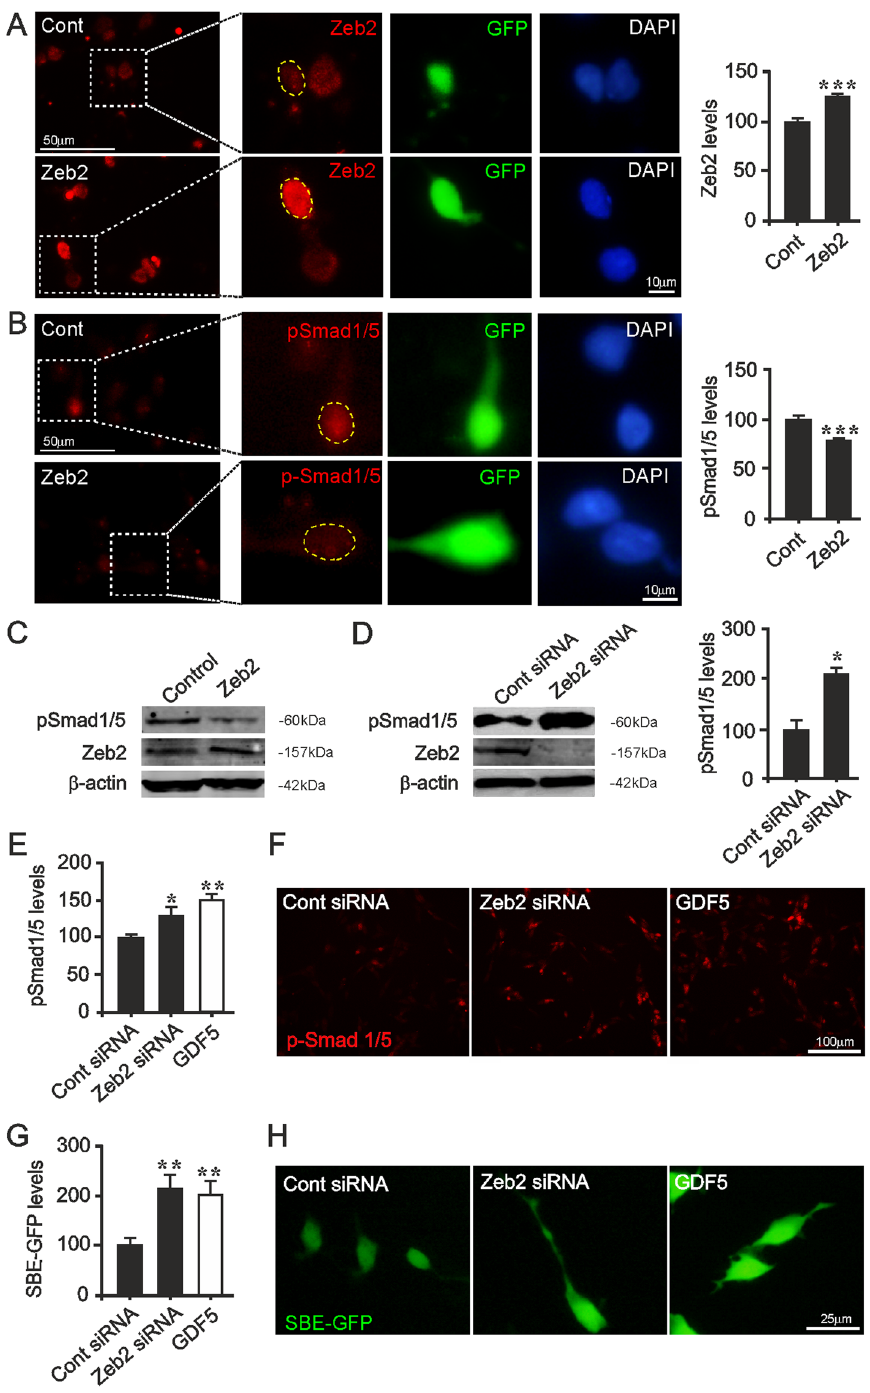
Figure 2. Zeb2 regulates p-Smad1/5 levels and p-Smad-dependent transcription. ( A ) Primary cultures of E14 rat VM neurons, transfected with a GFP expression vector and either a Zeb2 or control (Cont) expression vector, confirmed by immunocytochemistry with densitometry in GFP + cells at 24 h. ( B , C ) p-Smad1/5 levels as determined by ( B ) immunocytochemistry and ( C ) western blots in SH-SY5Y cells, and with densitometry in GFP + E14 VM rat neurons 24 h after transfection with control or Zeb2 expression vector ( B ). ( D , E ) p-Smad1/5 levels as determined by ( D ) western blots in SH-SY5Y and ( E ) E14 rat VM cultures 48 h after transfection with control siRNA or Zeb2 -targeting siRNA, or treated with 100 ng/ml GDF5. β -actin was used as a loading control. ( F ) Representative photomicrographs of p-Smad1/5 levels in cells treated with GDF5 or transfected with Zeb2 siRNA at 48 h. ( G ) Graph and ( H ) representative photomicrographs of the relative levels of SBE- GFP fluorescence in SH-SY5Y cells transfected with a SBE-GFP reporter vector with either a control siRNA or Zeb2 -siRNA, or treated with 100 ng/ml GDF5 for 24 h. All data are mean + SEM. (n = 3; * P < 0.05, ** P < 0.01, *** P < 0.001 vs. control; t-test or ANOVA with post hoc Tukey’s test). Scale bar as